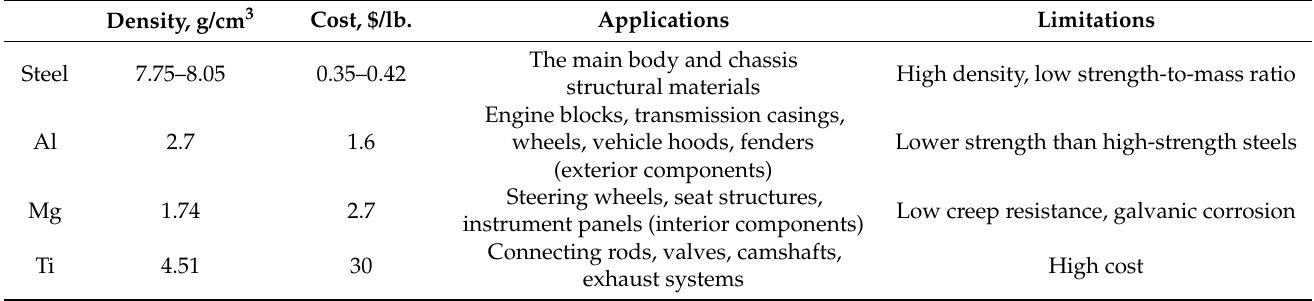
Table 1. A general comparison among steel, Al, Mg, and Ti alloys for automotive applications.